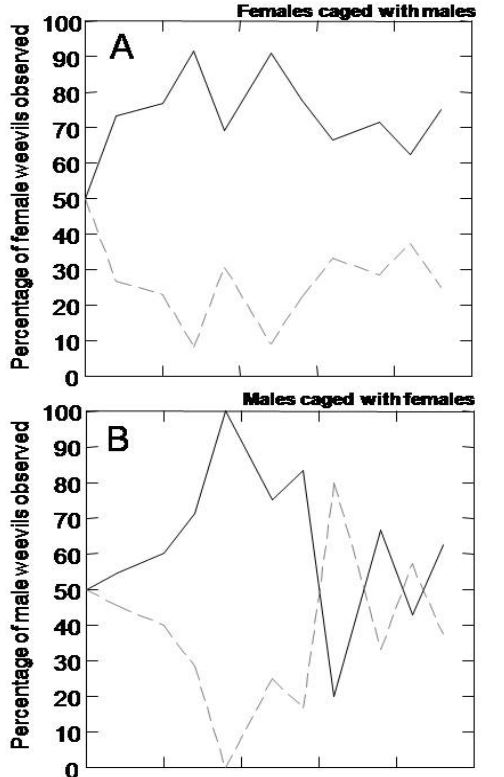
Figure 5. Female and male choice of resistant versus susceptible host tree genotypes. Weevil distribution on susceptible (solid lines) and resistant (dotted lines) trees in choice experiments. (A) The percentage of female weevils when mixed with male weevils; (B) male weevils when mixed with female weevils; and (C) male weevils only, observed on the susceptible and on the resistant genotypes at each sampling